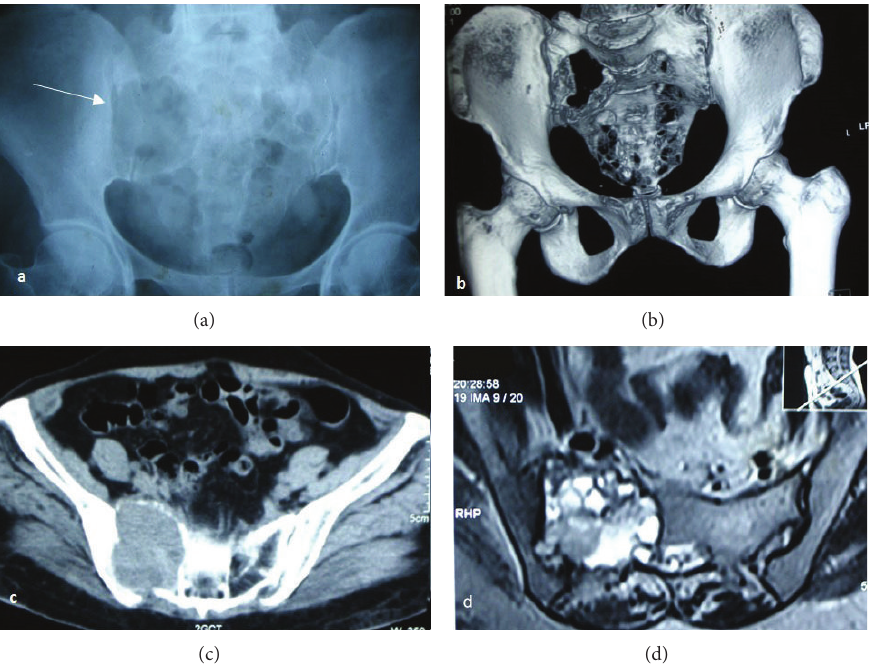
Figure 2: (a) Radiograph of the pelvis AP view; (b) 3D reconstruction and (c) axial section of CT showing expansile lytic lesion involving the right sacral ala with cortical break and surrounding soft-tissue component extending into right SI joint space and pelvis measuring 5.2 × 5.7 × 6.3 cm eroding the adjacent iliac bone. Mass extending into the sacral canal. (d) MRI showing large expansile heterogeneous lobulated lesion with few septations involving right sacroiliac joint. Predominantly lytic lesion with cortical destruction features suggestive of GCT.